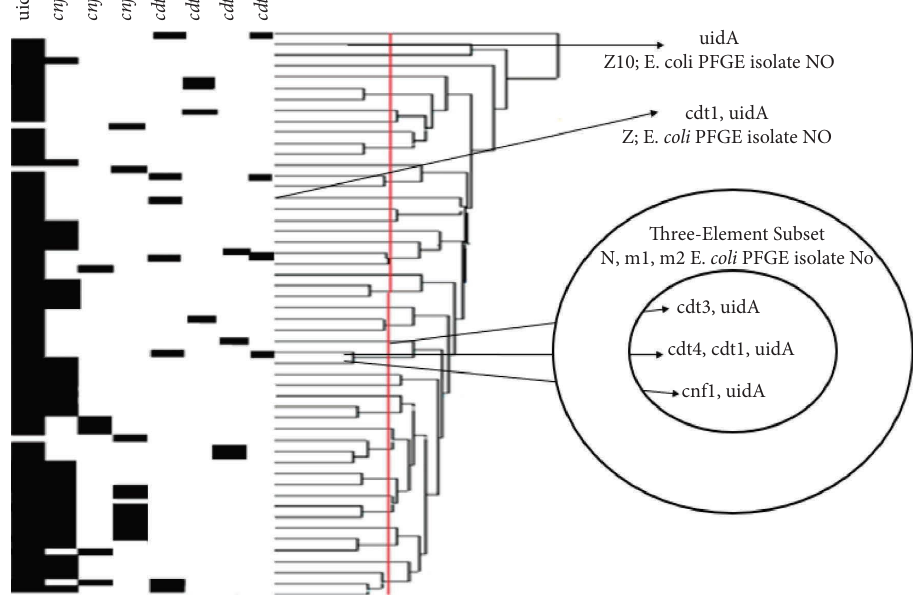
Figure 7: Clustering of virulence